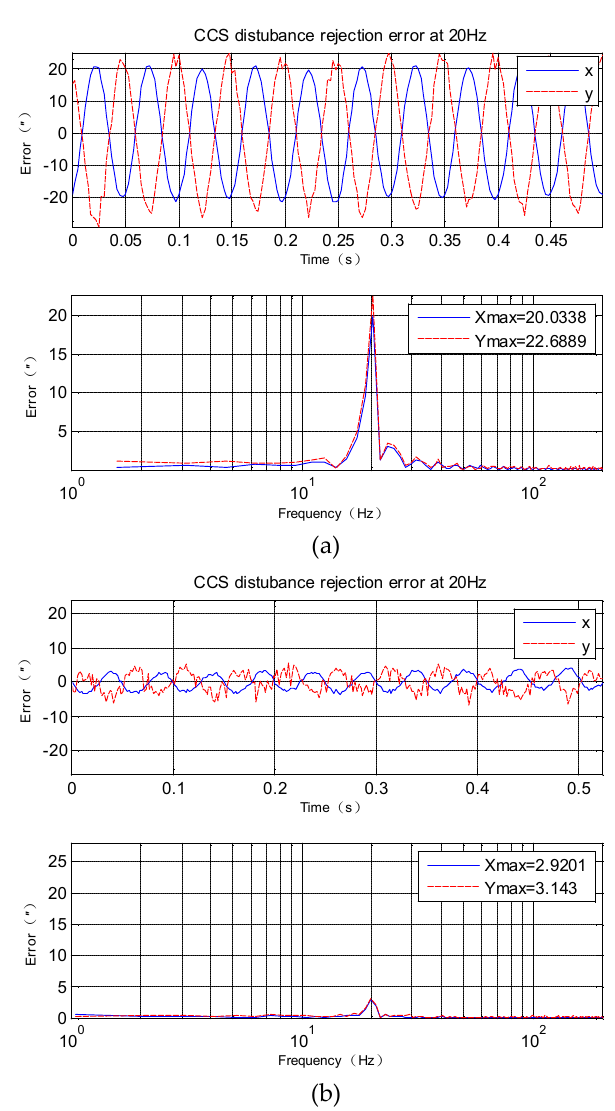
Figure 8. X -axis and Y -axis disturbance rejection error at 20 Hz. ( a ) disturbance rejection error of CCS; ( b ) disturbance rejection error of CS-FC.